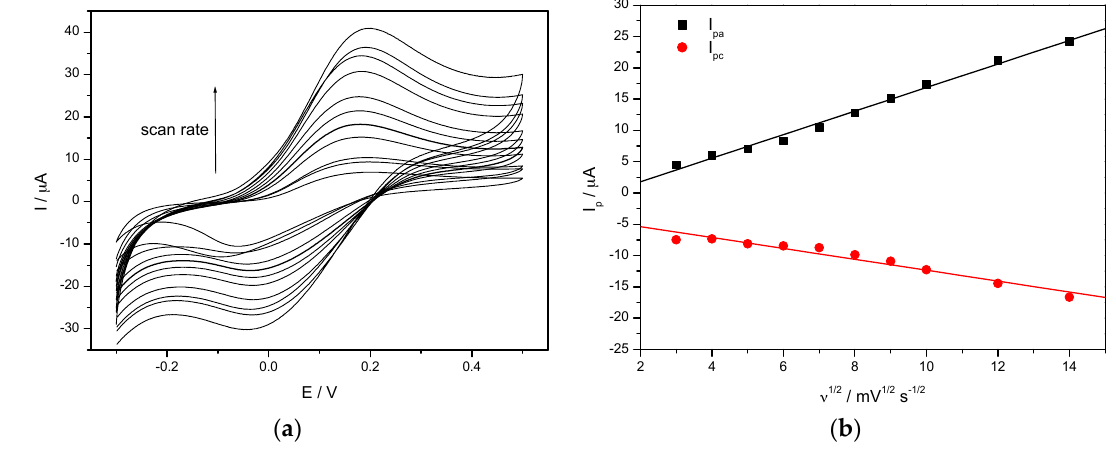
Figure 8. ( a ) CVs of poly(2,6-DHN)/SPCE in 0.1 M PBS pH 9.0 containing 50 µ M PON at scan rates from 9 to 250 mV · s − 1 . Potential range: − 0.3 V to +0.5 V; sensor modified by electropolymerization of 2,6-DHN with the scan rate of 5 mV · s − 1 . ( b ) Plot of the anodic and cathodic peak currents vs. square root of scan rate ( ν 1/2